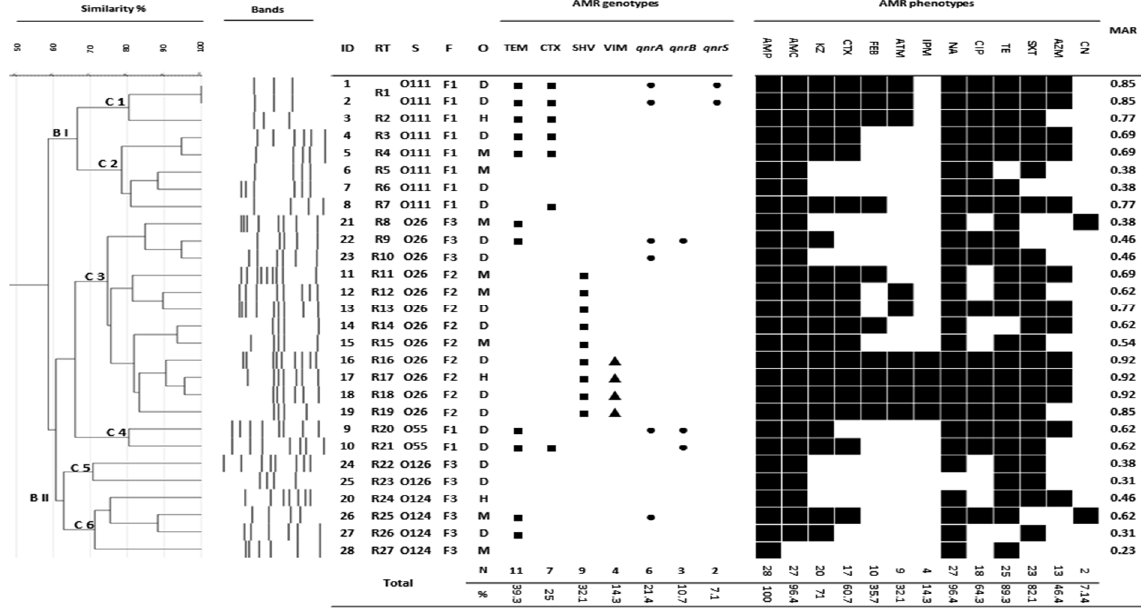
Figure 1. REP-PCR genotyping, virulence genes, and AMR of EPEC isolates recovered from diarrhoeic calves, milk, and workers in studied dairy farms. ■ , ESBL genes; ▲ , CR genes; ● , PMQR genes.